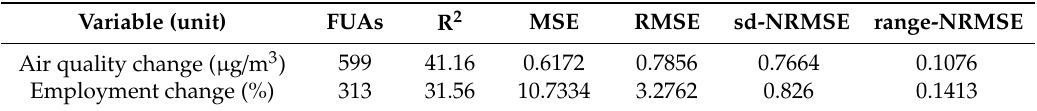
Table 3. Accuracy statistics for multi-temporal change models. Air quality and employment rate change regression models for the period between 2000 and 2014 by means of spatio-temporal metrics. FUAs is the total number of FUAs included in the model; R 2 , the coe ffi cient of determination; MSE, the mean square error; RMSE, the root mean square error in the same units as the variable; and sd-NRMSE and range-NRSME are the standard deviation and range-based normalized RMSE,